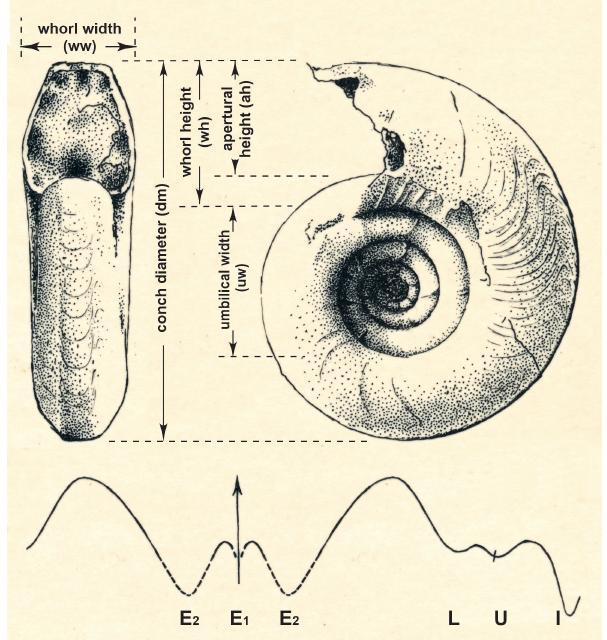
Fig. 3. The morphological terms used in the description of the ammonoid conchs and suture lines. Illustration from an ink drawing of Acanthoclymenia neapolitana (Clarke, 1892) by Jerzy